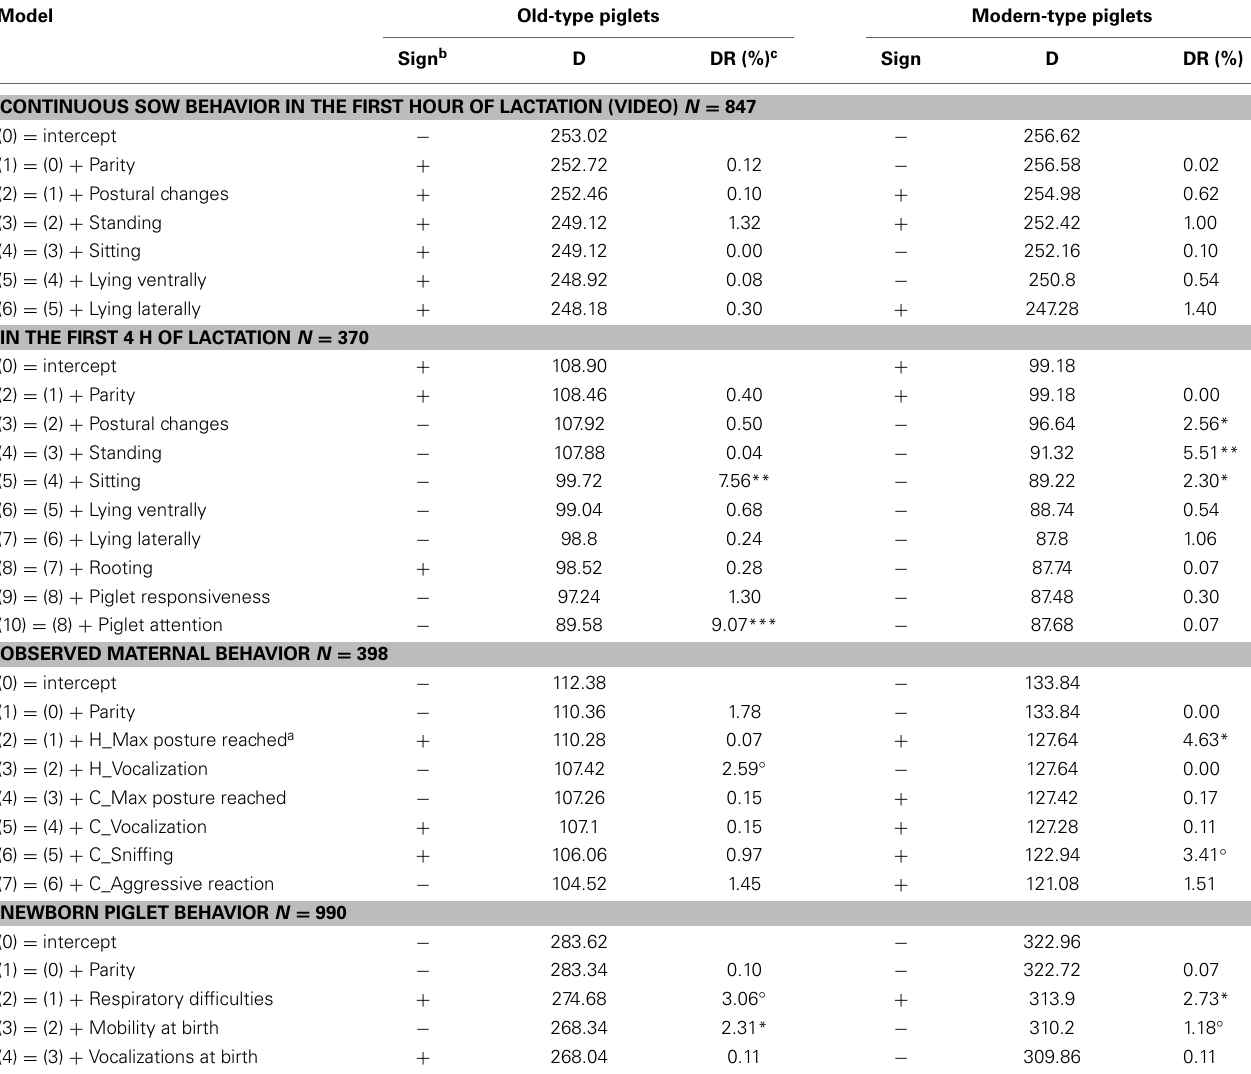
Table 8 | Association between probability of death in the first 2 days after birth and sow and piglet